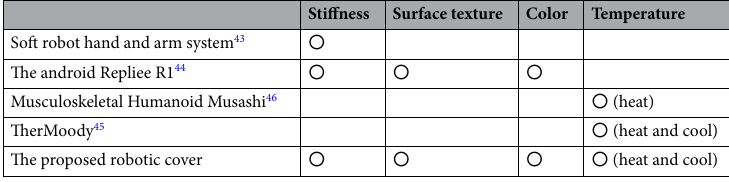
Table 1. The proposed robotic cover compared with the several